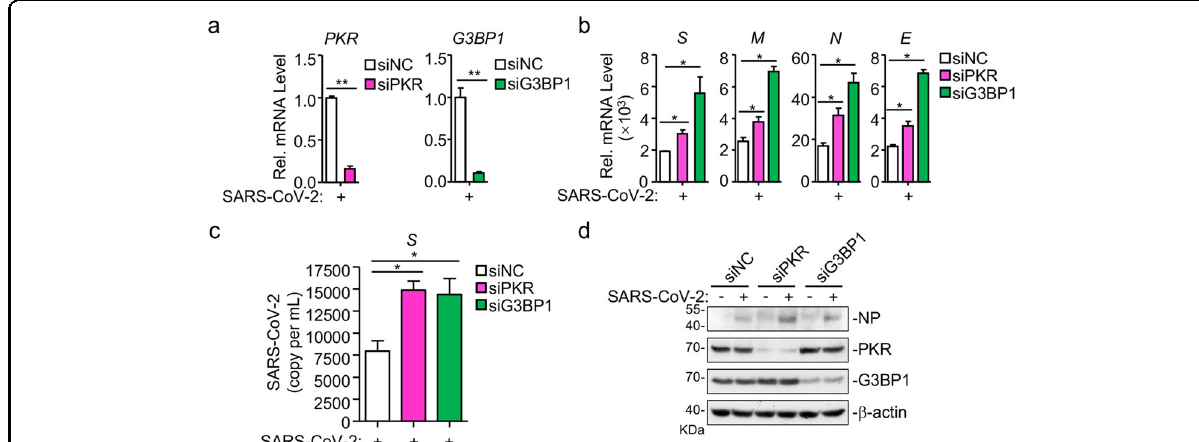
Fig. 2 Knockdown of PKR and G3BP1 facilitates viral replication. a , b De fi ciency of PKR or G3BP1 promotes the transcription of SARS-CoV-2 genes. HeLa-ACE2 cells were transfected with siRNAs speci fi c for PKR (siPKR) or G3BP1 (siG3BP1) or control siRNA (siNC) for 48 h. The cells were then infected with SARS-CoV-2 (MOI = 0.01) for 24 h before qPCR analysis with the indicated primers. c , d Knockdown of PKR or G3BP1 promotes SARS- CoV-2 replication. HeLa-ACE2 cells were transfected with siRNAs speci fi c for PKR (siPKR) or G3BP1 (siG3BP1) or control siRNA (siNC) for 48 h. The cells were then infected with SARS-CoV-2 (MOI = 0.01) for 24 h. Virus yield in the infected cell supernatants was quanti fi ed by qPCR analysis with primers based on RBD of SARS-CoV-2 S gene ( c ), and NP expression in infected cells was analyzed by immunoblot with the indicated antibodies ( d ). Graphs show means ± SD, n = 3. * P < 0.05, ** P < 0.01 (Student ’ s t-